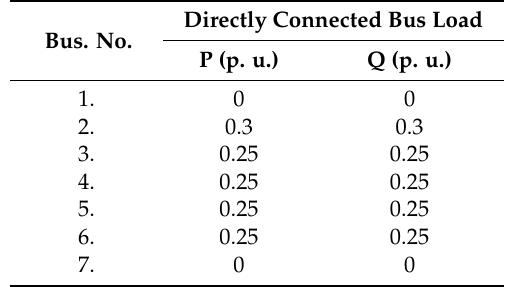
Table 2. System connected